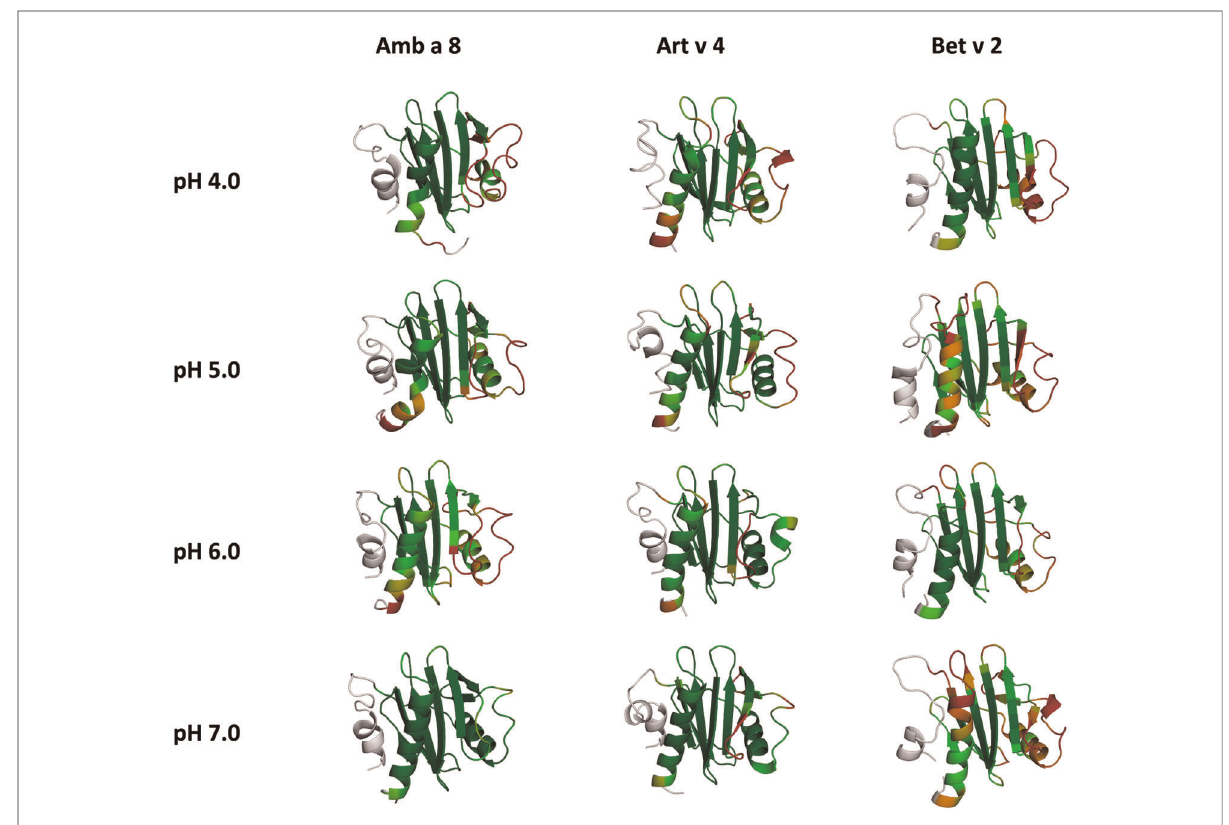
FIGURE 6 Residues-wise B-factors are mapped onto the structures of the most populated clusters of the 1 µs cpH-MD simulation. The more fl exible regions are colored in dark-red, while the more rigid parts of the protein are depicted in